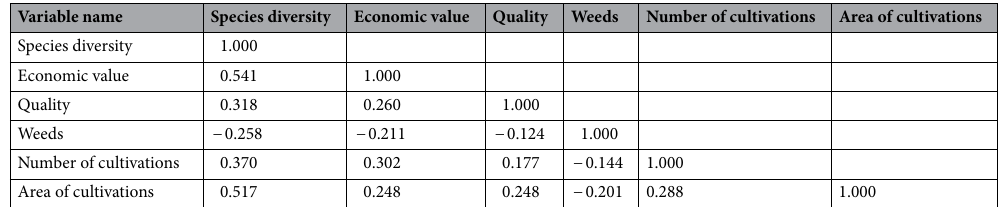
Table 5. Correlation matrix for ecological outcome indicators. Correlation matrix for the continuous reflective indicators (species diversity, economic value, quality, weeds, number of cultivations and area of cultivations) measuring the latent variable Ecological outcome. All correlations are significant ( p value <